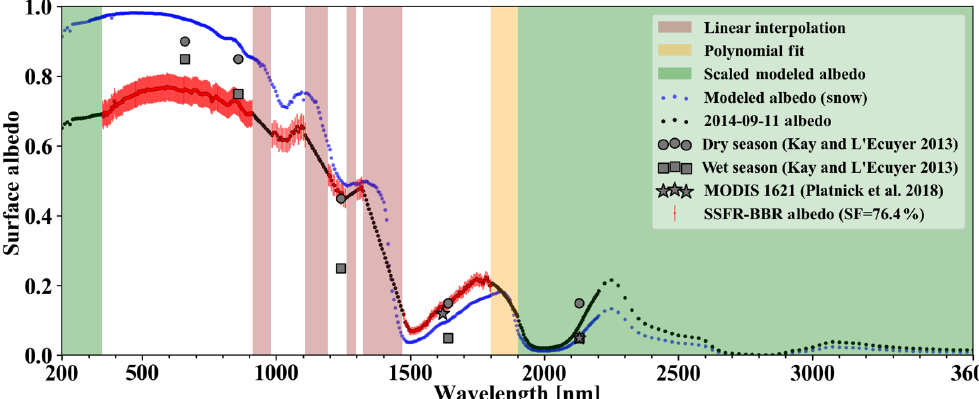
Figure 6. Spectral surface albedo (black) along with their uncertainties used in the RTM for the 11 September 2014 calculations. The spectral albedo uses the SSFR–BBR-derived albedo with SF = 76.4% (red) except for the wavelength ranges marked (1) in green replaced by scaled modeled snow albedo (blue), (2) in red (gas absorption bands) linear interpolation, and (3) in yellow (1800 to 1900nm) polynomial fit using SSFR–BBR-derived albedo from 1650 to